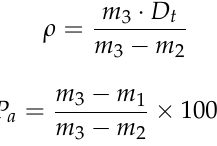
Figure 2. Schematic diagram of the preparation process of the C f /SiC-Al 2 O 3 composite. After PIP process, the SiC overcoating was deposited using CVD method [27], where